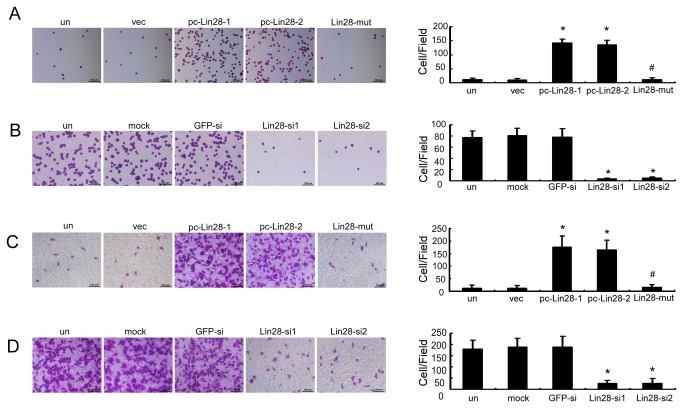
Lin28 promotes adhesion and migration in breast cancer cells.A and B. Cell adherence assays revealed that Lin28 stably expressed MCF-7 clones pc-Lin28-1 and pc-Lin28-2 adhered better to the ﬁbronectin-coated surface than empty vector and Lin28-mut transfectants (A). Meanwhile, cell adherence was remarkably decreased in MDA-MB-231 cells that had been transfected with Lin28-siRNA (B). C and D. Using Boyden chambers, cell migration was significantly increased in pc-Lin28-1 and pc-Lin28-2 MCF-7 cells (C), whereas it was significantly reduced in MDA-MB-231 cells after transfection with Lin28-siRNA (D). Error bars correspond to the mean ± SD. *P < 0.01as compared to the vec or GFPsi treatment group. Bars, 100 μm.